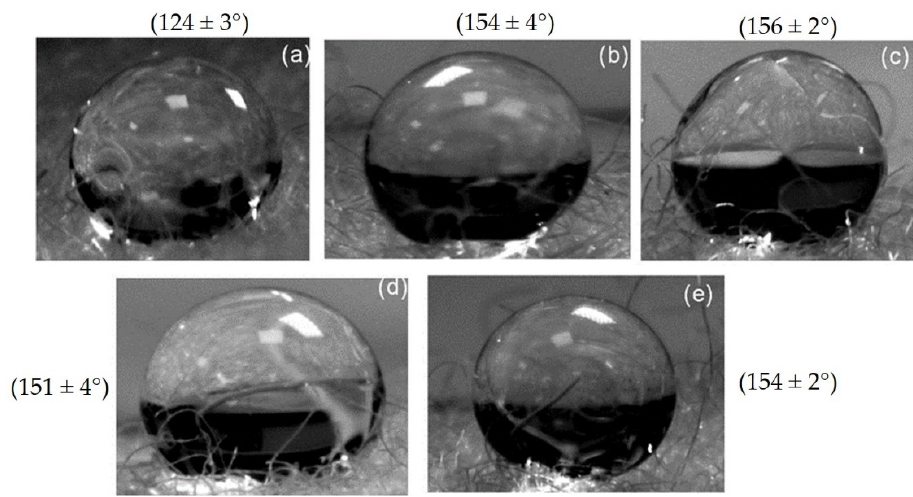
Figure 7. Water droplets on different scoured wool samples as captured by a digital camera: ( a ) untreated, ( b ) 80 W 6 m 50 sccm, ( c ) 80 W 20 m 50 sccm, ( d ) 150 W 6 m 12 sccm, and ( e ) 150 W 20 m 12 sccm (the contact angles are provided within brackets).